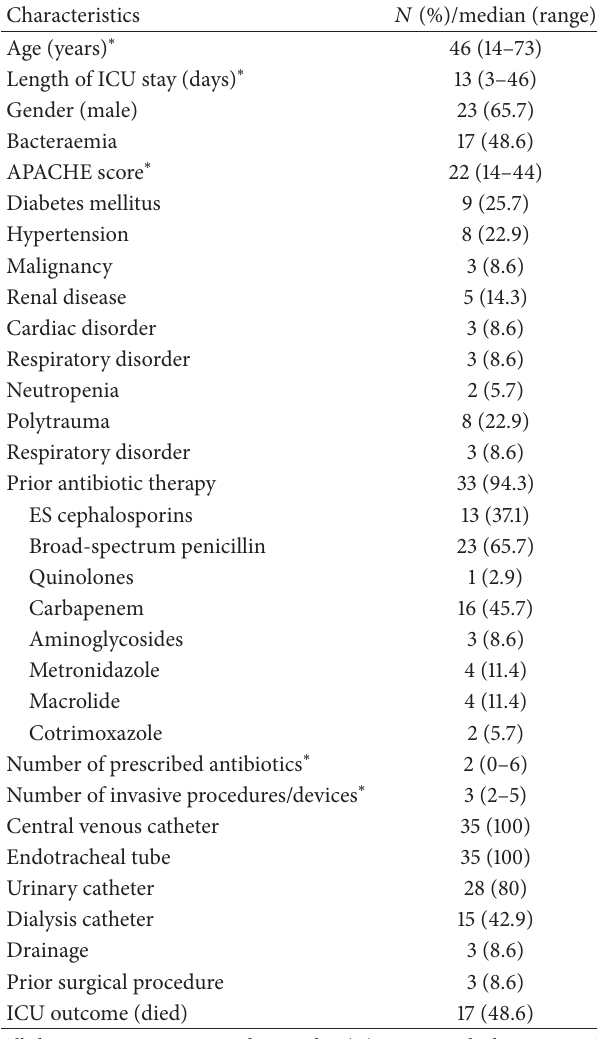
Table 1: Clinical characteristics of 35 patients with ACB Complex.